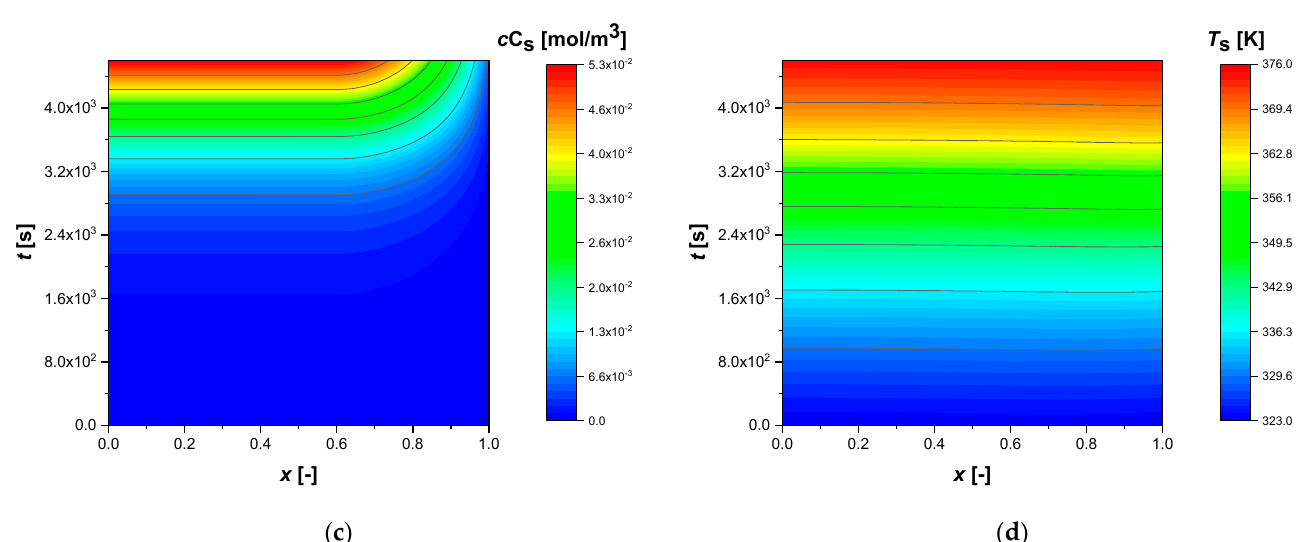
Figure 1. Intraparticle profiles for ES catalyst. Calculated profiles for: cA ( a ), cB ( b ), cC ( c ) and Ts ( d ). Color-bar of each plot is located on the right-hand-side.